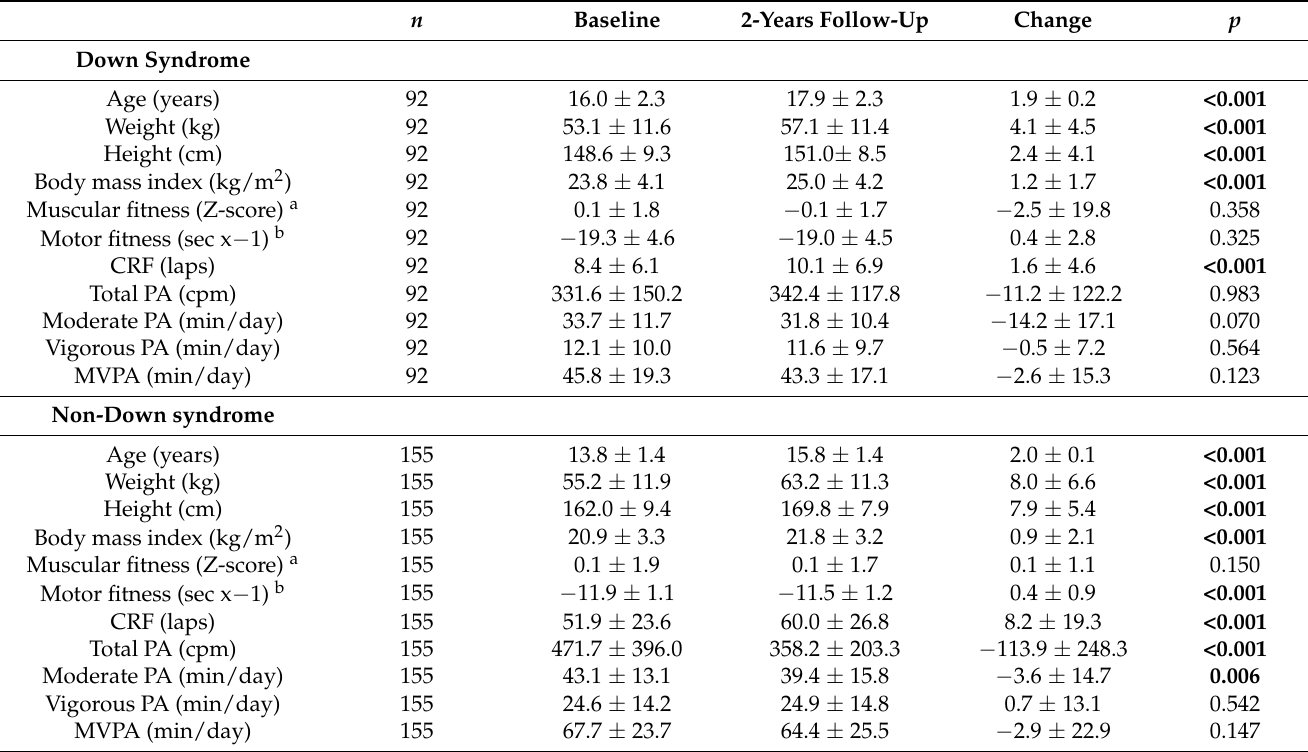
Table 1. Descriptive characteristics of study samples at baseline and follow-up.